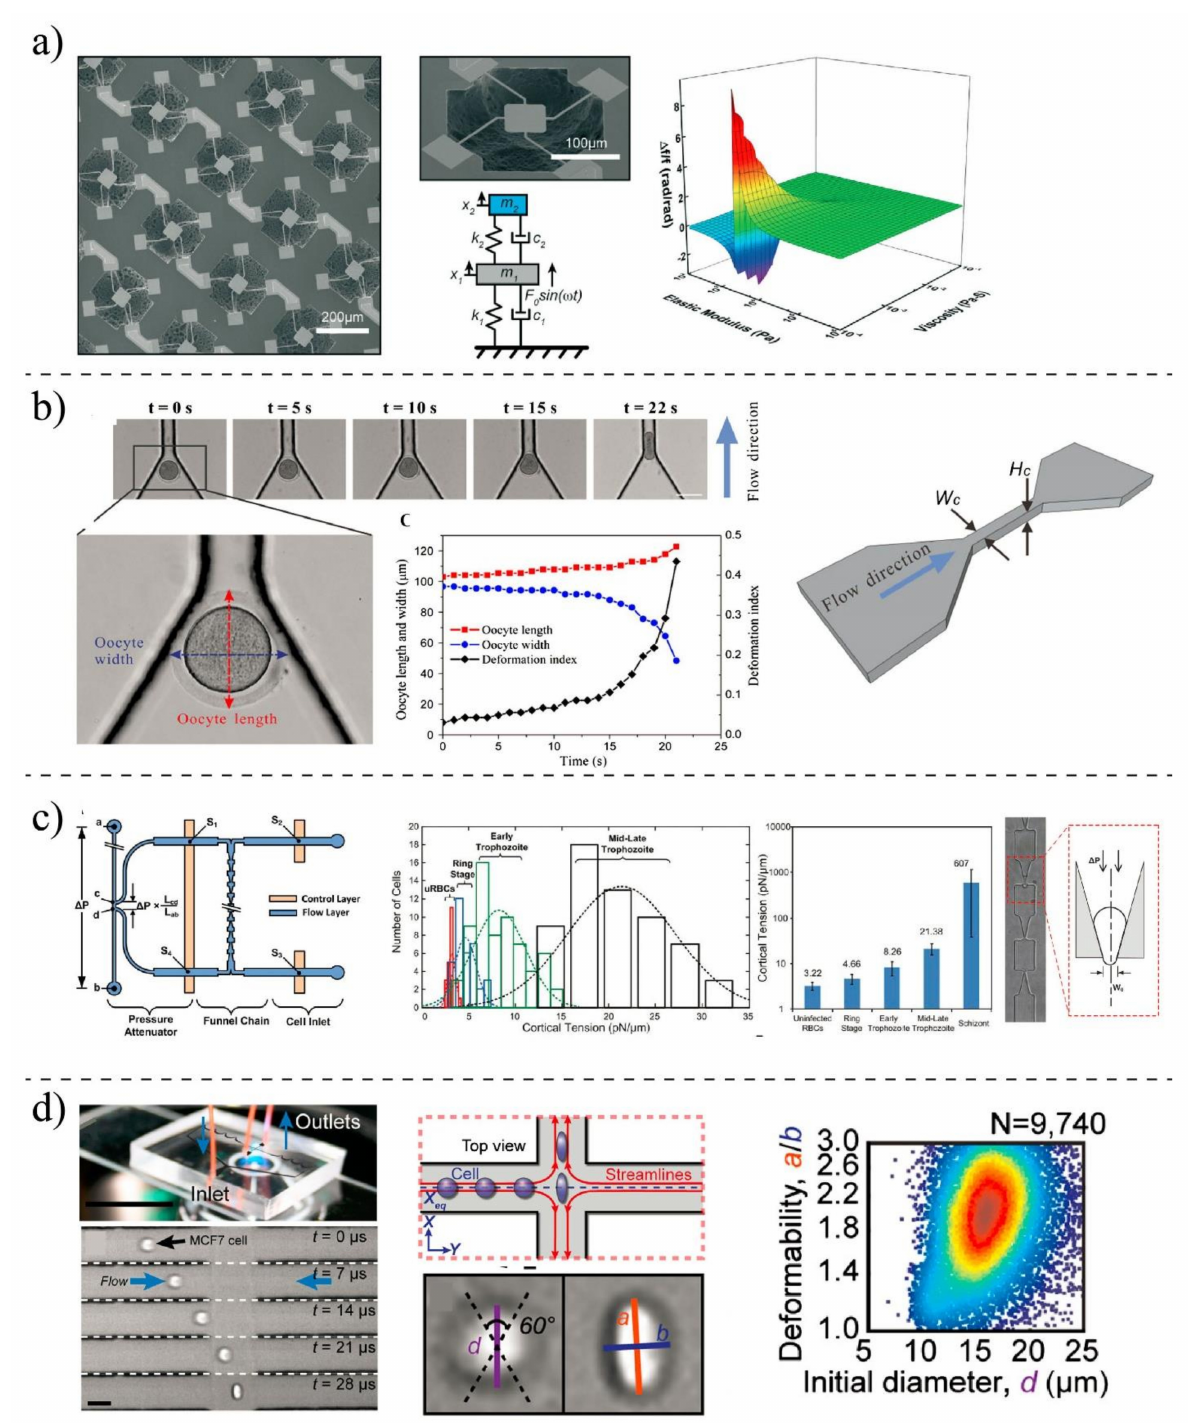
Figure 6. Different microfluidic and MEMS techniques for the mechanobiological characterization of cells: ( a ) Modeling cells as a two-degrees-of-freedom system and measuring their viscoelastic properties using a MEMS resonator. Reprinted with permission from [115]. Copyright Royal Society of Chemistry 2015. ( b ) Constriction channels to induce mechanical deformation onto oocyte cells and measuring their deformations as they pass through the tight channel. Adapted with permission from [135]. Copyright Springer Nature 2015. ( c ) A micro-aspiration integrated into a constriction channel for quantifying the deformability properties of cells by measuring the threshold pressures. Reprinted with permission from [136]. Copyright Royal Society of Chemistry 2012. ( d ) Hydrodynamic stretching of cells and high-throughput assay to measure the index of cells and investigate the deformability of cells. Reprinted with permission from [102]. Copyright (2012) National Academy of